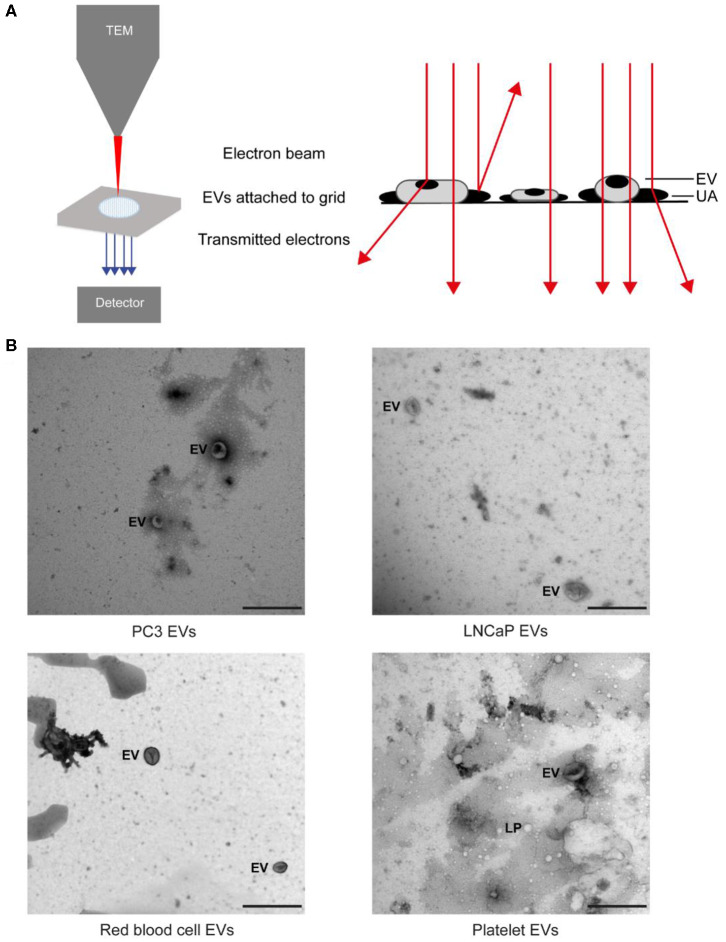
Transmission electron microscopy (TEM) of extracellular vesicle (EV) samples. (A) Schematic representation of TEM imaging for EV samples. The sample on a grid is exposed to an electron beam, and images are constructed based on the detected transmitted electrons. The uranyl acetate (UA) scatters electrons efficiently, which results in negative contrast. EVs and lipoproteins (LPs) have a low electron density and are seen as bright particles in a dark background (13). (B) TEM images of the EV samples from PC3 and LNCaP and of red blood cells and platelets after size exclusion chromatography. The scale bar corresponds to 500 nm (25).